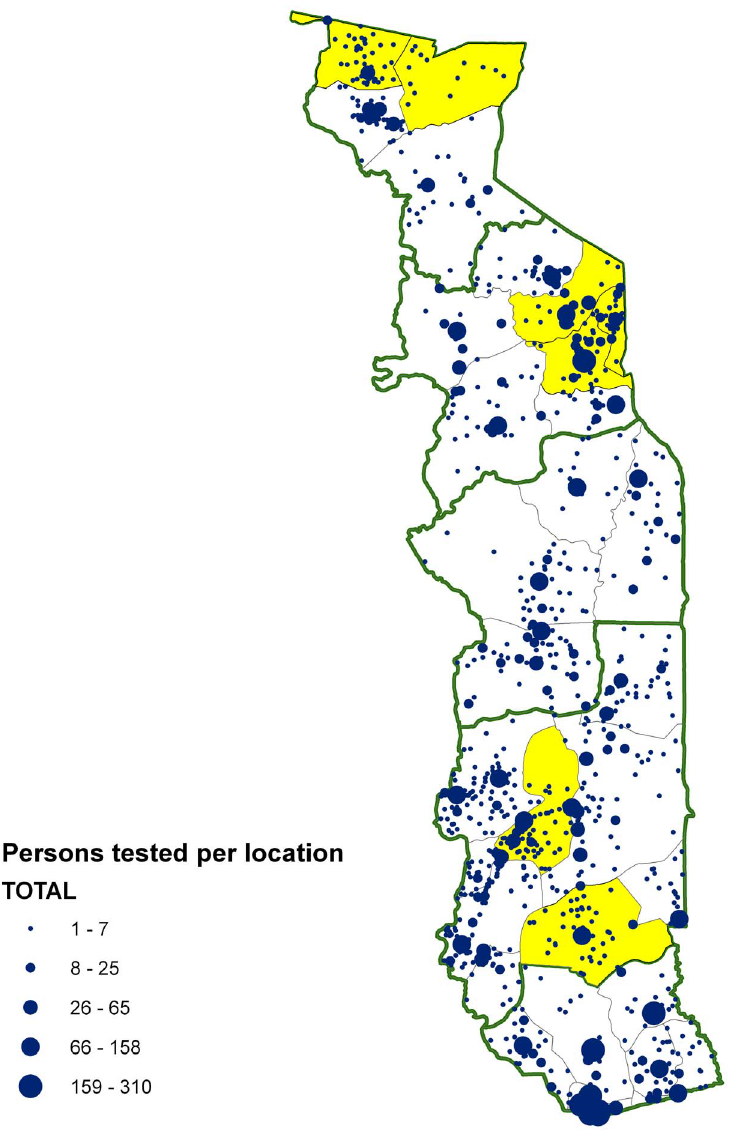
Figure 3. Geographic coverage of the LF surveillance system, 2006–2007.